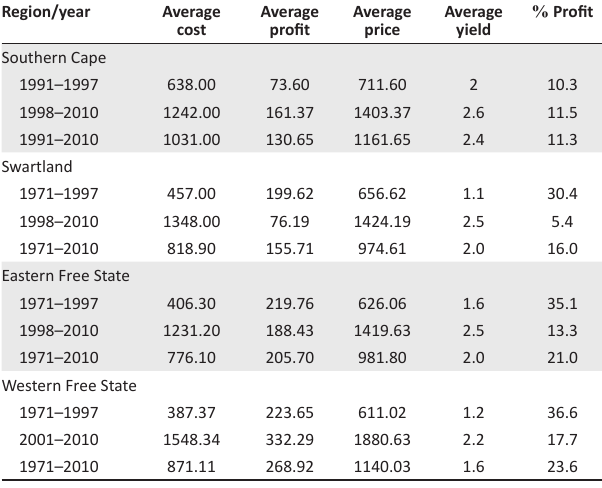
TABLE 1: Profitability of the wheat market in South Africa (Own calculations from Appendix